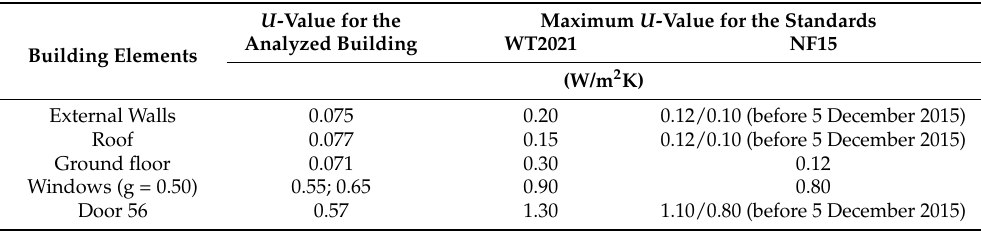
Table 2. Heat transfer coefficient ( U -value) requirements for the WT2021 and NF15 standards [119,123] and achieved for the analyzed building [135].